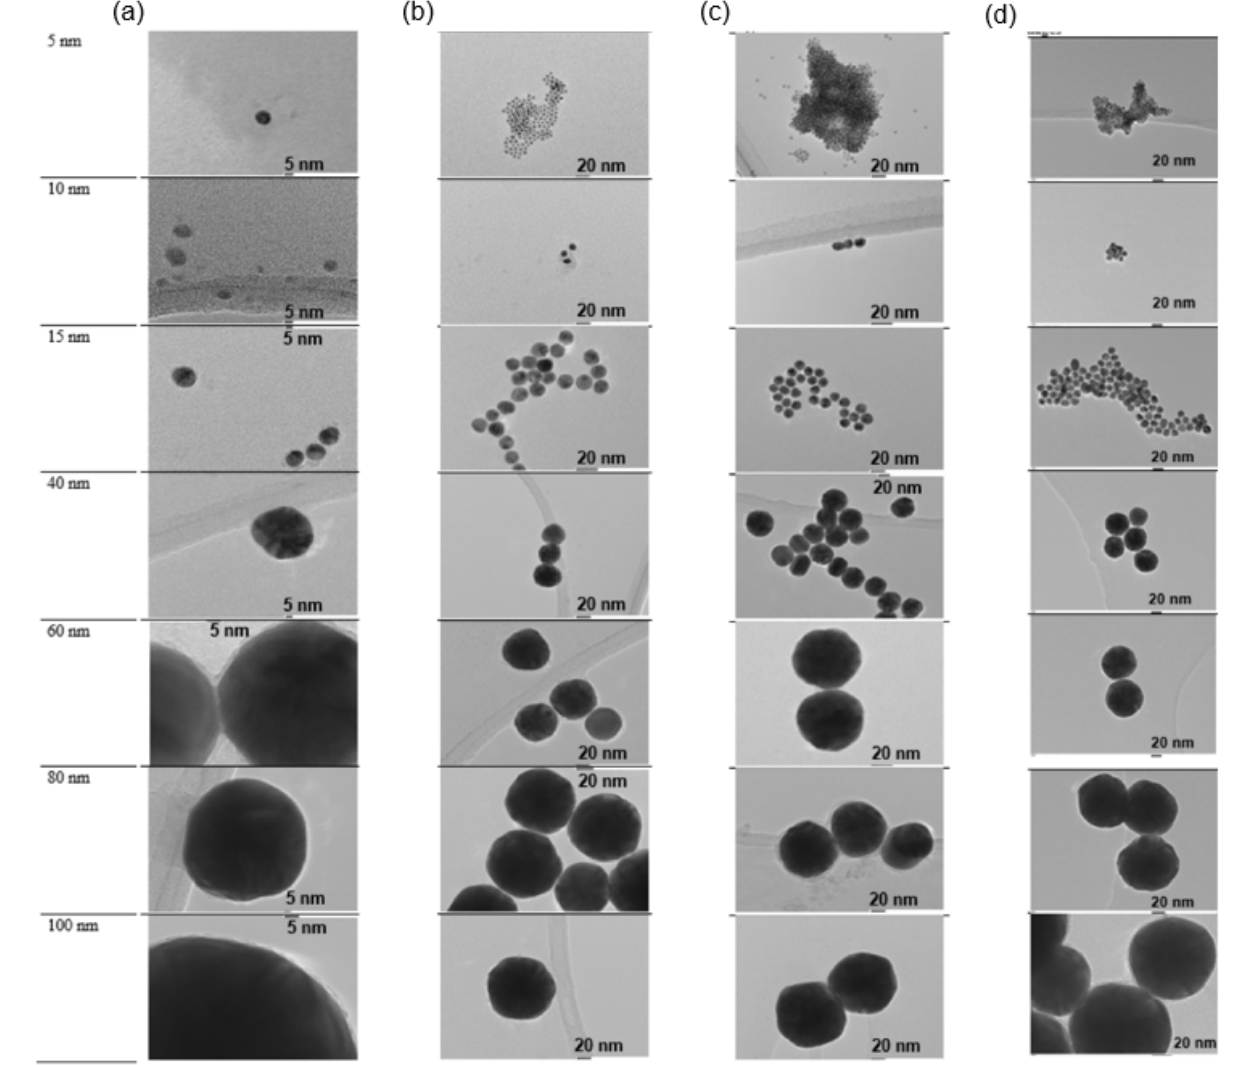
Figure 2. TEM images of ( a ) 4-MBA, ( b ) 2-NT, ( c ) 4-AATP, and ( d ) BPT labeled AuNPs of different sizes ranging between 5 nm and 100 nm. Scale bar: 5 nm in ( a ); 20 nm in ( b – d ).